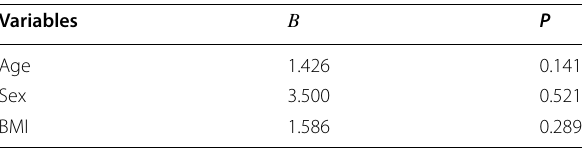
Table 5 Regression analysis for prediction of factors affecting